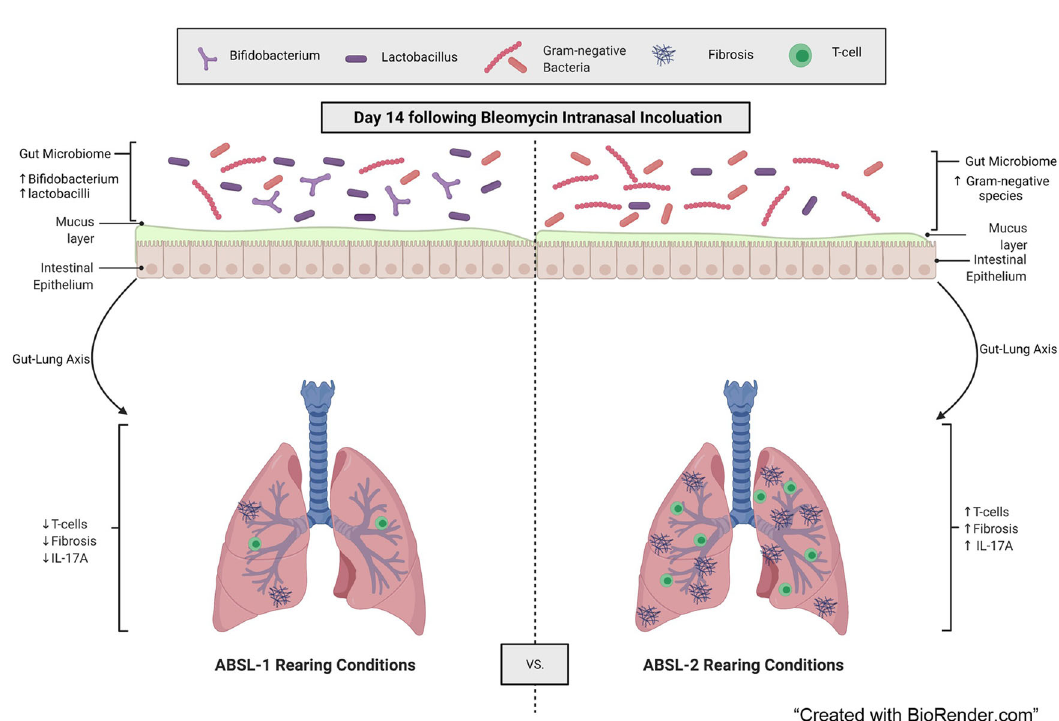
Fig. 7 Model of gut contribution to fi brotic lung disease. Direct modulation of the gut microbiota in a bleomycin-induced murine model suggests that a functional gut-lung axis attenuates lung fi